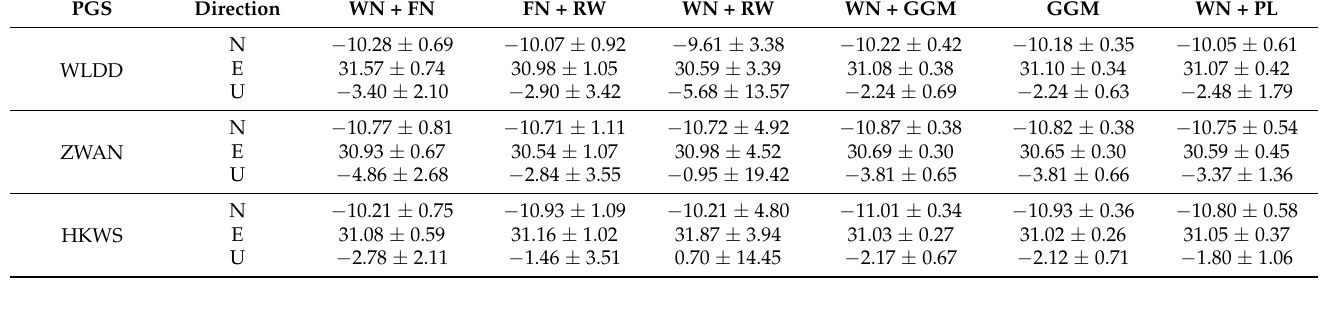
Table 2. PGS velocity of the WSCS. (Unit: mm/year).